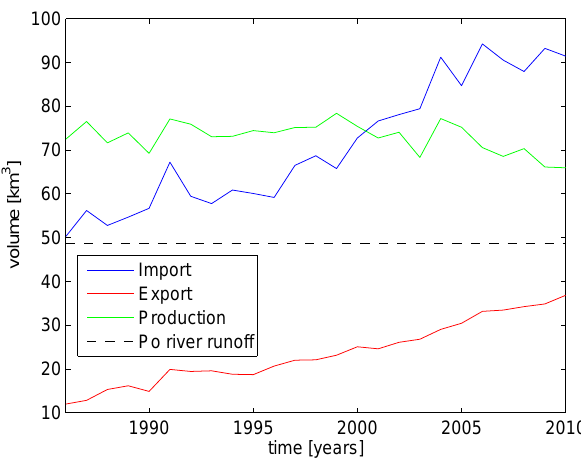
Fig. 5. Variation in time of the mean distance travelled by virtual water entering Italy (import) or flowing out of Italy (export).